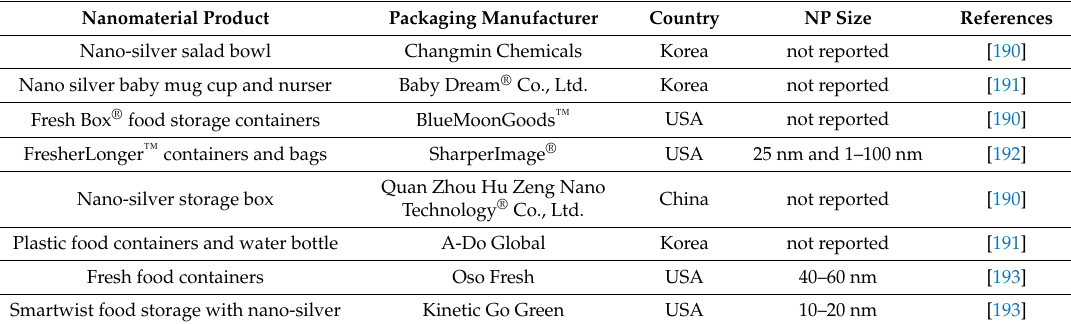
Table 3. Applications of AgNPs in food industry. Adapted from [25], with permission from